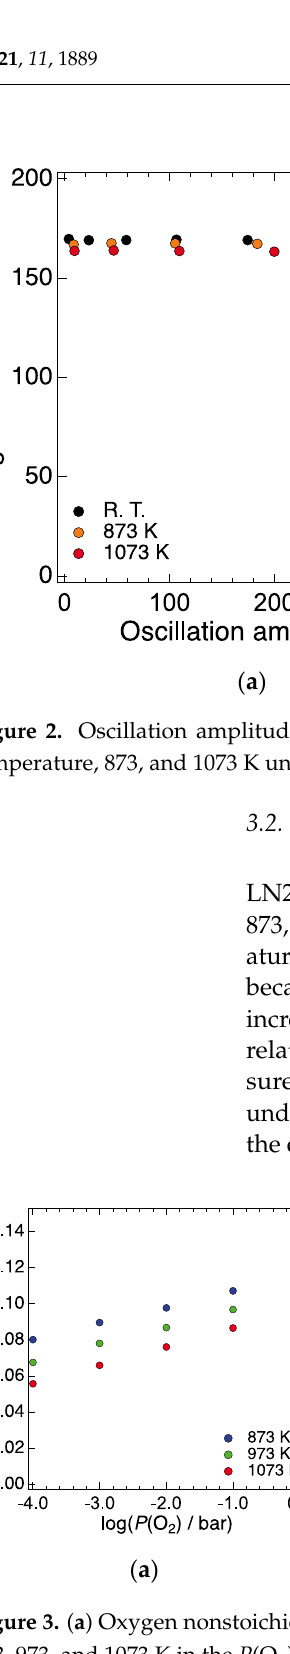
( a ) ( b ) ( c ) Figure 4. P (O 2 ) dependence of ( a ) the Young’s modulus, ( b ) shear modulus, and ( c ) internal friction of LN214, respectively, at 873, 973, and 1073 K.